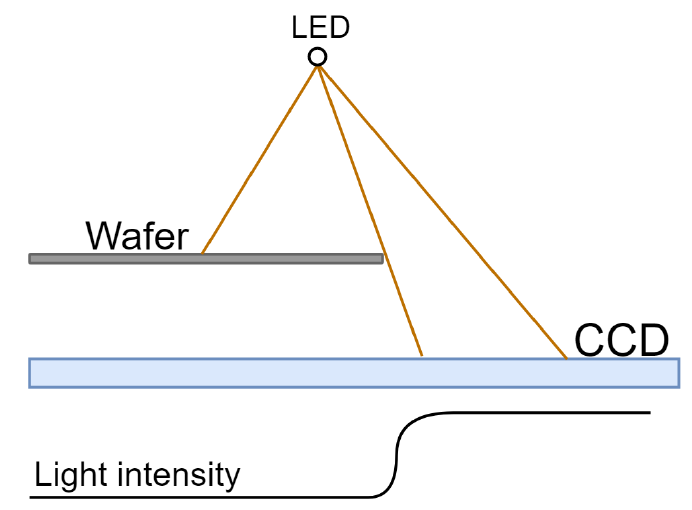
Figure 17. Linear CCD sensor concept to measure the edge of a wafer.